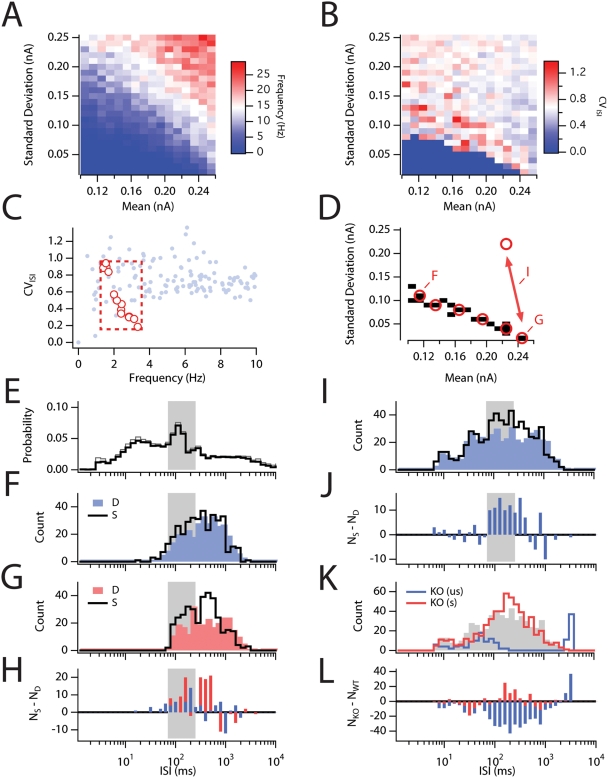
Effects of stochastic channel gating alter the response to stellate
cells to naturalistic stimuli.(A,B) Plot of mean spike frequency (A) and coefficient of variation of
the ISI distribution (B) as a function of the mean and standard
deviation of band limited white noise inputs obtained from 5 s duration
simulations (N = 384). (C) CV plotted
as a function of mean firing frequency for the same data shown in A and
B. The frequency and CV of several recordings (see [49]) from
neurons in the superifical layers of the medial entorhinal cortex
in vivo are plotted for comparison (red dots).
These values from in vivo data were used to define a
region of stimulus space selected for further analysis (red box). (D) A
masked plot of stimulus space shows the simulations that resulted in
values within the red box defined in C. Longer simulations (150 s) were
run for the points indicated in red using both the deterministic and
stochastic models. (E) The mean ISI probability density for experimental
recordings plotted in C. Gray shaded region indictates the range of ISIs
for spike clusters (see text). (F, G) ISI histograms obtained
from simulations with the deterministic (“D”) and
stochastic (“S”) versions of the model using input
statistics at the extrema of the plot in D (indicated by
“F” and “G”). (H) The difference
in spike counts between the D and S simulations for the data plotted in
F (blue) and G (red). The stochastic model shows a selective
redistribution in the probability of spiking that produces an increase
in the clustering interval (shaded region) and a decrease at longer ISI
intervals. (I) ISI histograms obtained from simulations with
deterministic (blue) and stochastic (black) versions of the model using
input statistics that fluctuate randomly between the two states
indicated by the double-headed arrow in D. (J) The difference in spike
counts between the D and S simulations for the data plotted in I. (K)
ISI histogram for response of the knockout model to the unscaled
(“us”; blue) and the scaled
(“s”; red) poisson stimuli (see text). Gray shaded region is the data from I replotted. (L) The
difference in count between the “us” and
“s” simulations for the data plotted in K. All
histograms use exponentially spaced bins.